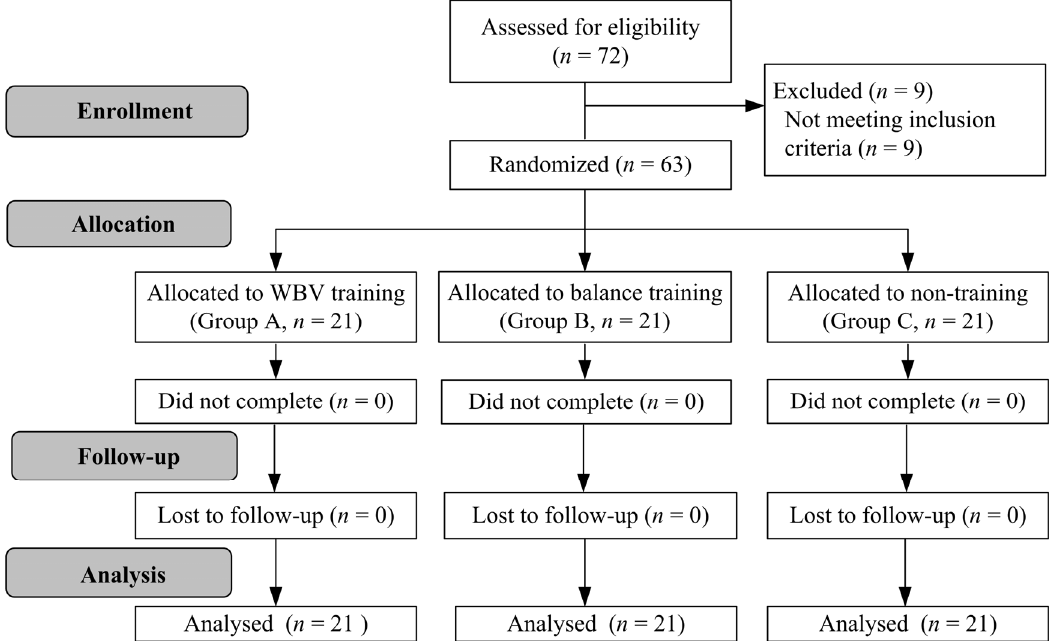
Figure 1. Flowchart of the current study. WBV: whole-body vibration